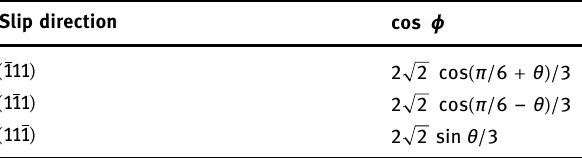
ϕ cos of the involved slip planes